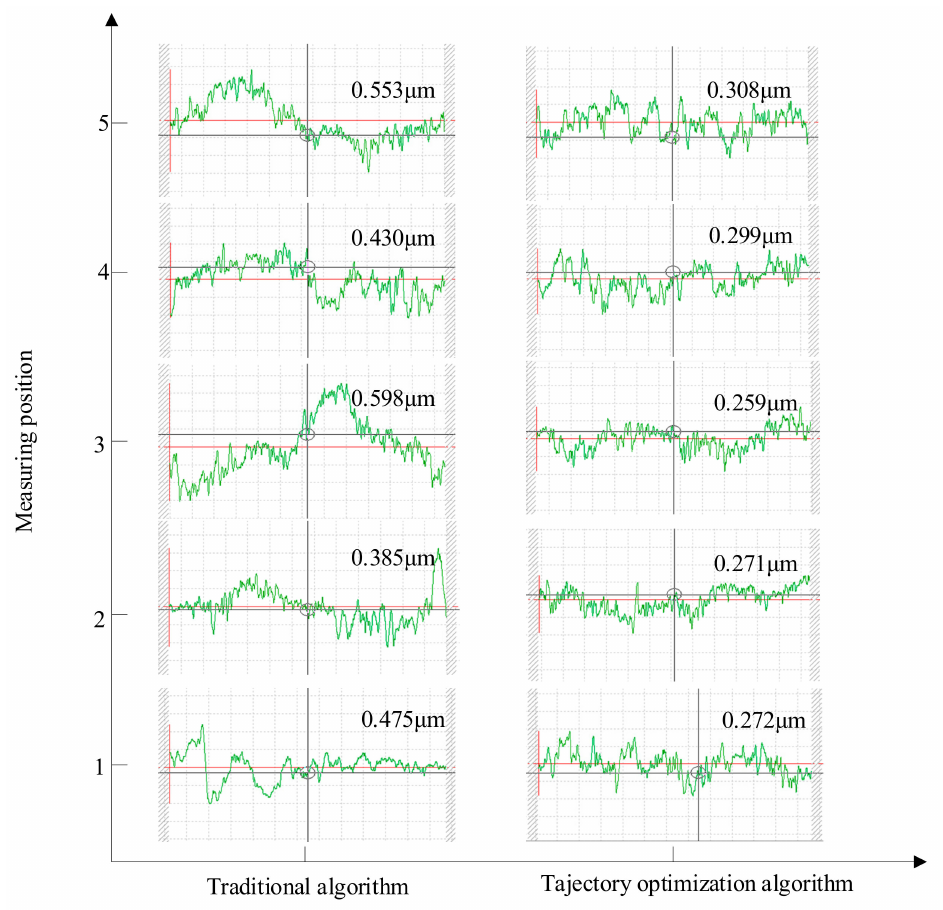
Figure 19. Roughness comparison in five regions under the two